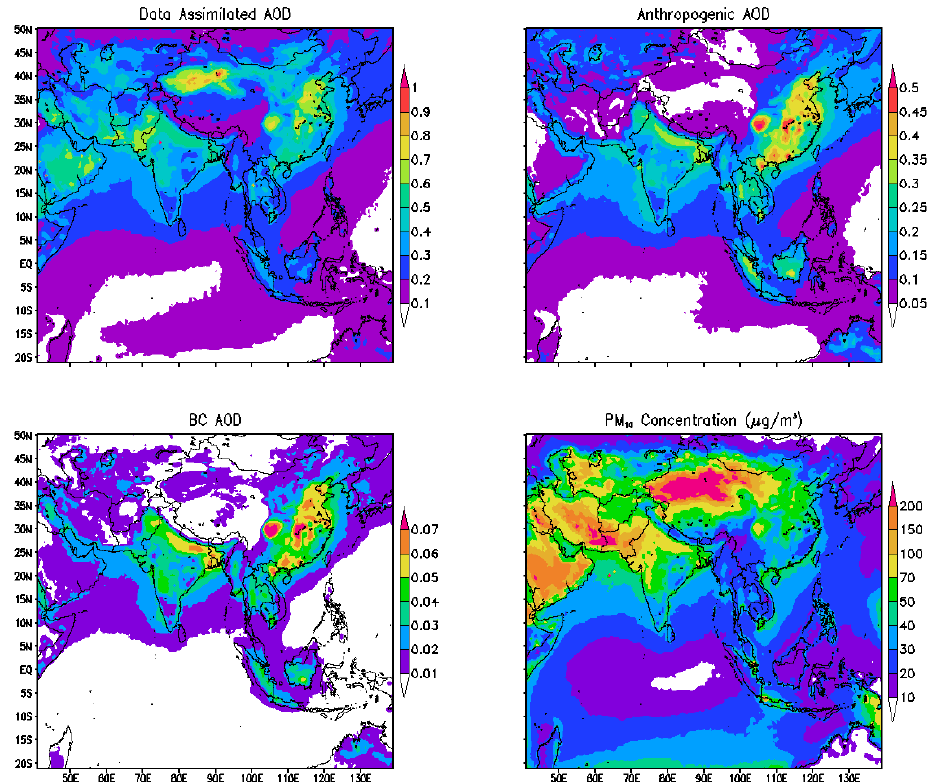
Fig. 4. Four-year mean model fields after assimilation of AOD, anthropogenic AOD, BC AOD and surface PM 10 mass concentration (µg/m 3 ). 4 Anthropogenic aerosol